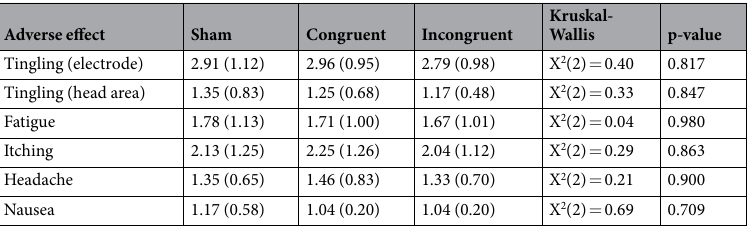
Table 2. Adverse effects of tDCS. Data are mean values of a 1–5 Likert scale with standard deviations in